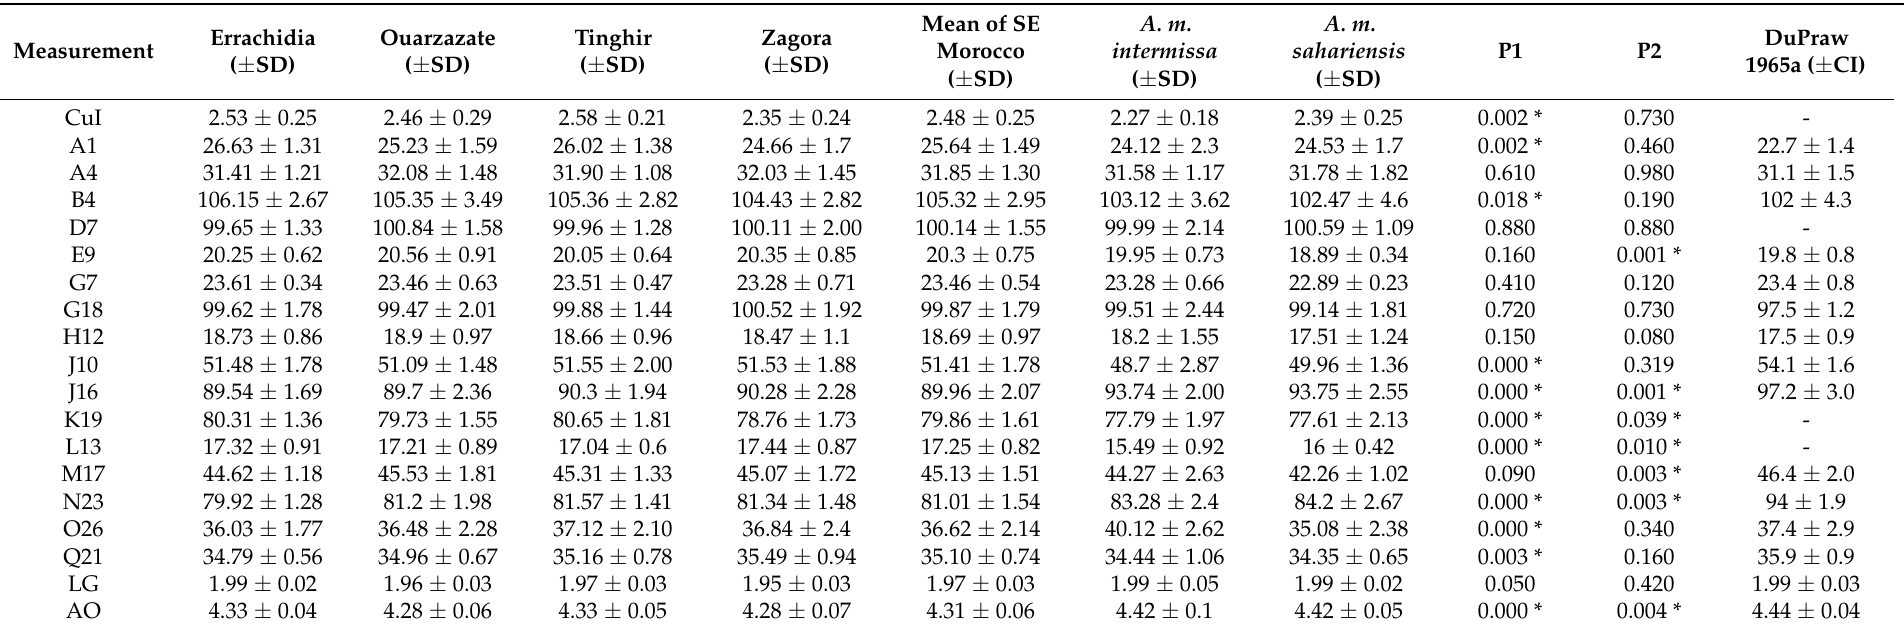
Table 2. Wing shape of honey bees from four areas of SE Morocco and reference samples of A. m. sahariensis and A. m. intermissa described by traditional morphometric indexes. For comparison we provide data for bees from Sahara published by DuPraw [5]. P1 and P2 indicates significance of differences in pairwise comparisons between samples from southeastern Morocco and A. m. intermissa and A. m. sahariensis respectively. SD–standard deviation, CI–95% confidence interval. The asterisk (*) indicate significant difference at p <